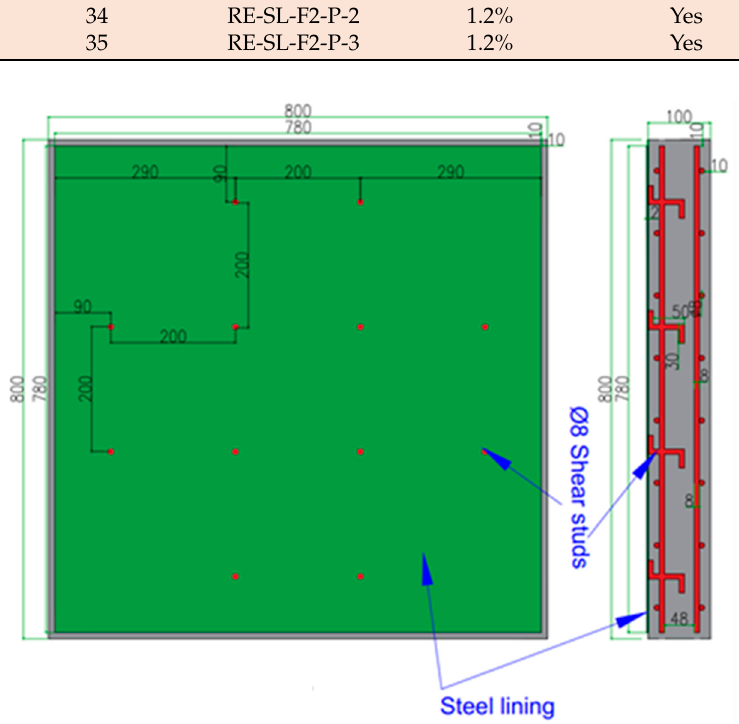
Figure 3. Details of steel-lined RC slabs (All dimensions are in mm).